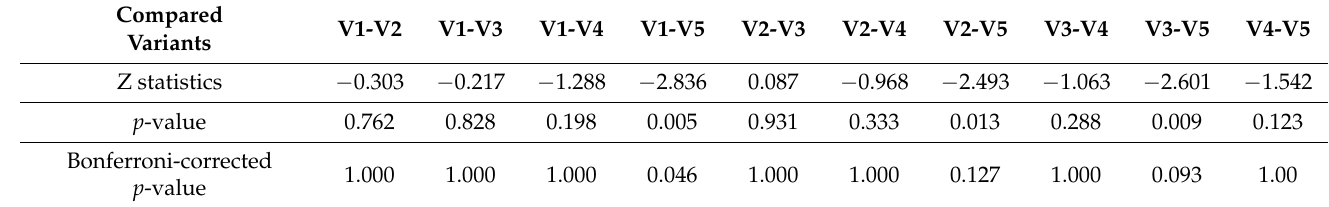
Table 4. Post Hoc Comparisons for Different Framing